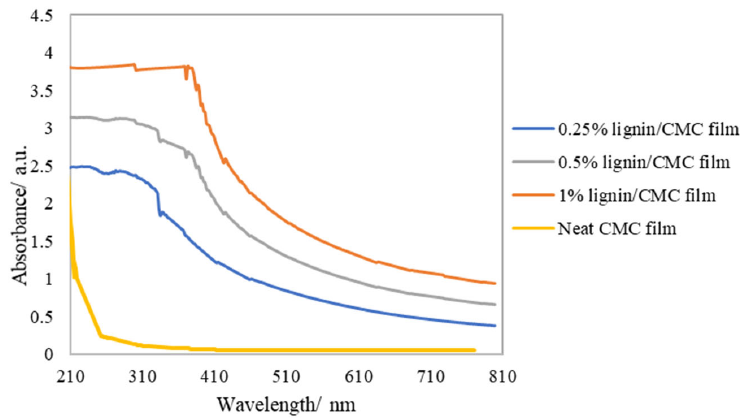
Figure 3. UV/vis spectra of lignin/CMC films, recorded from 210–800 nm.